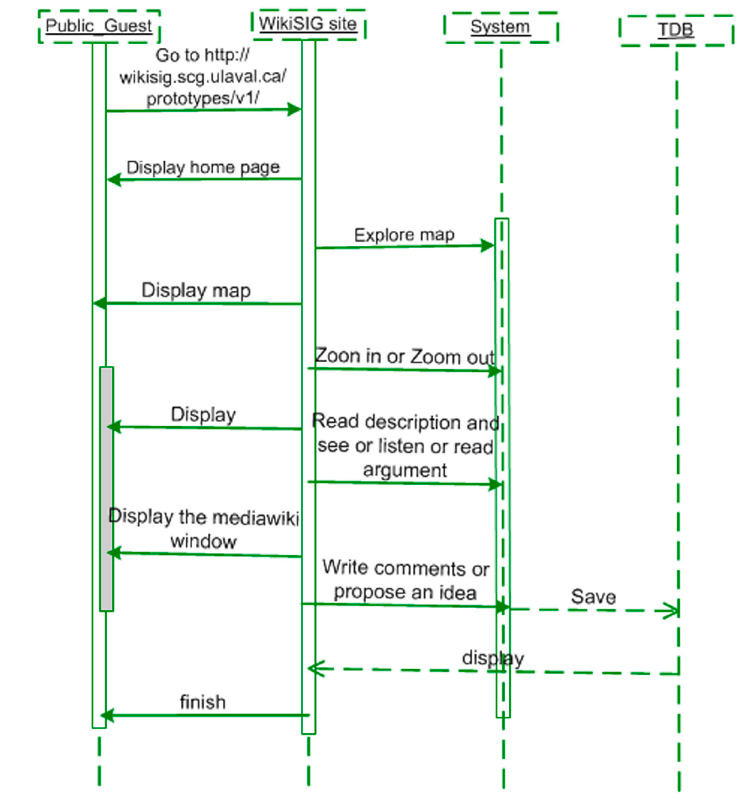
Figure 20. Sequence diagram of the not connected